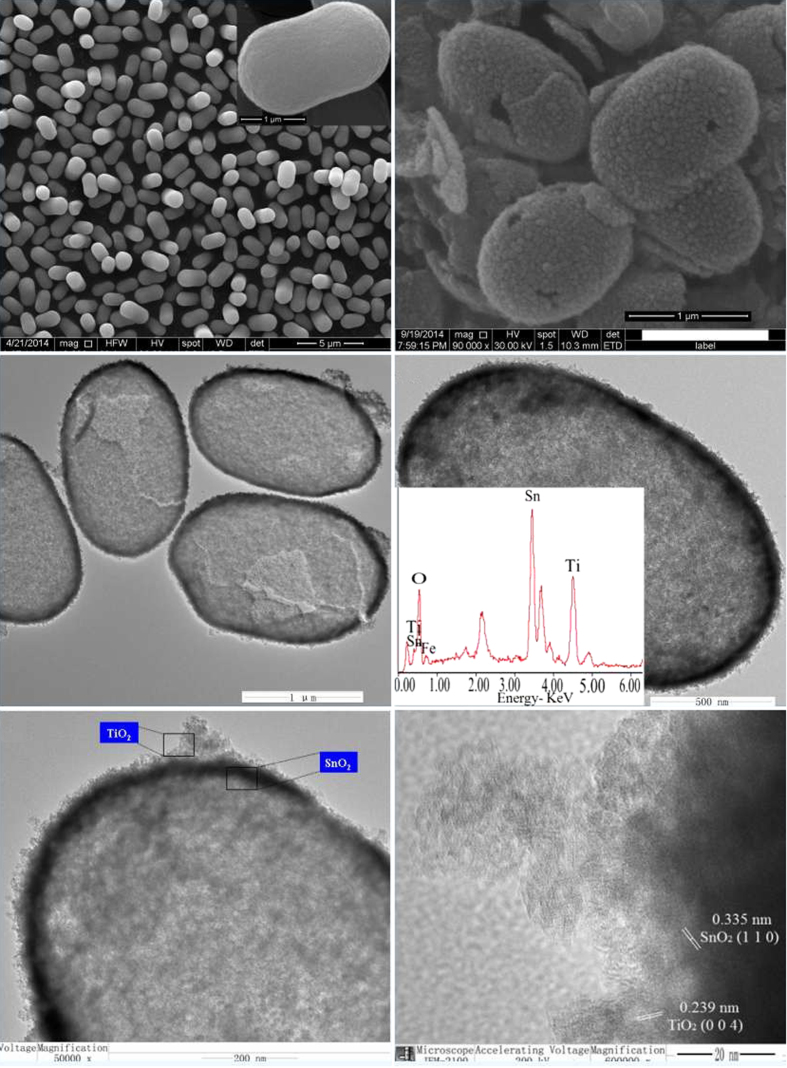
SEM images of monodisperse α-Fe2O3 particles with capsule shapes(a).SEM image (b), TEM images (c–e), and HRTEM micrographs (f) of as-synthesized hollow SnO2@TiO2 nanocapsules. The inset in (d) shows EDX analysis.